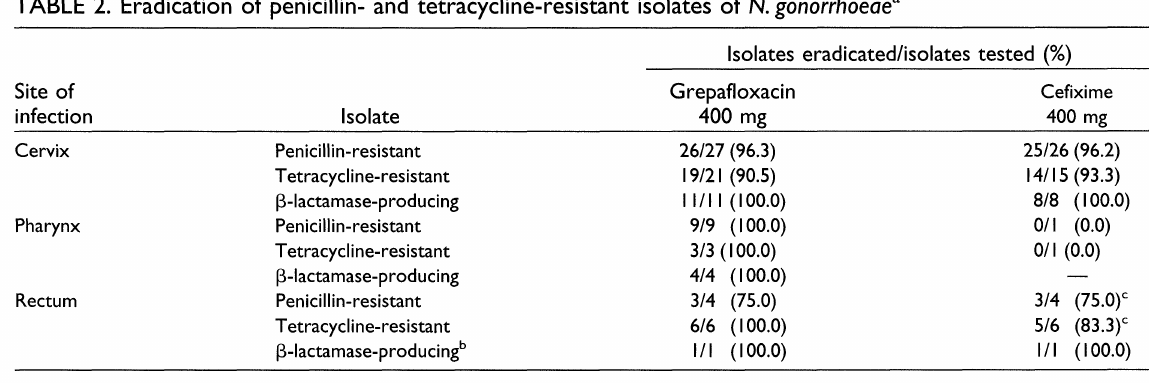
Isolates eradicated/isolates tested (%)